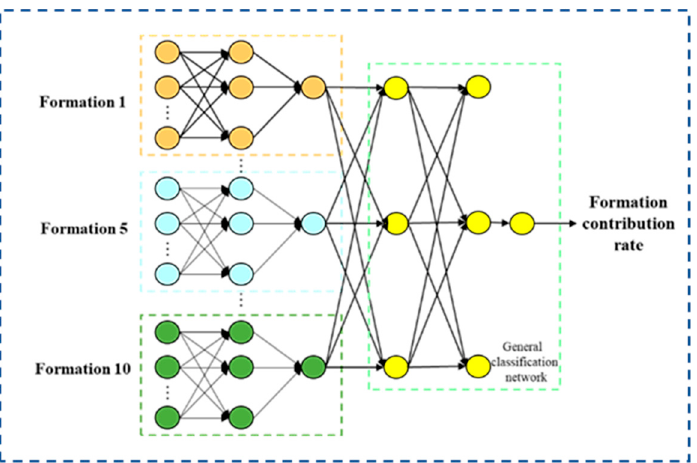
Figure 9. Network diagram of random forest classifier. The back propagation includes an input layer, a hidden layer, and an output layer. a hidden layer, and an output